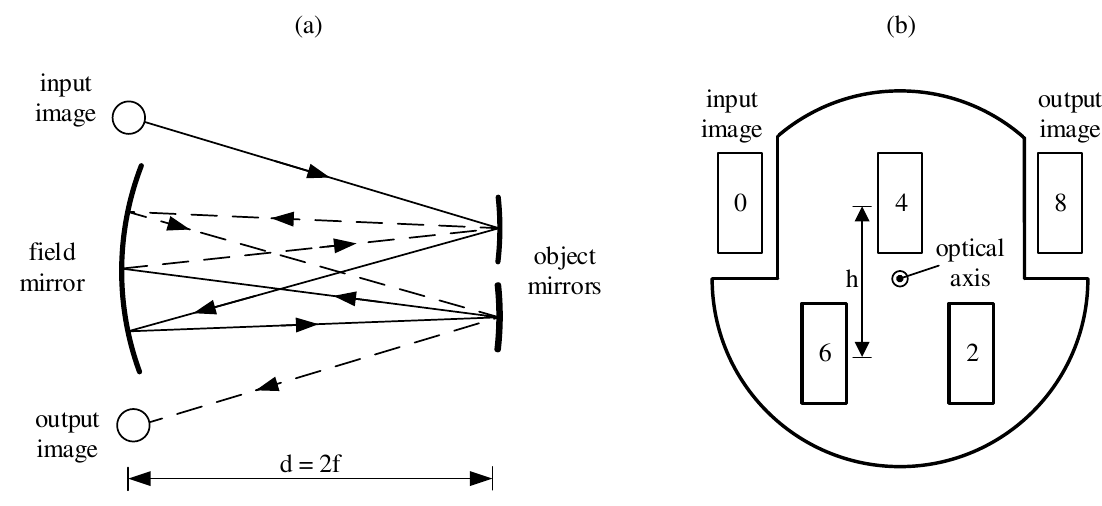
Figure 2. ( a ) Basic set-up of the White cell and focal rays for eight passes; ( b ) Schematic layout of the field mirror with indicated numbers of